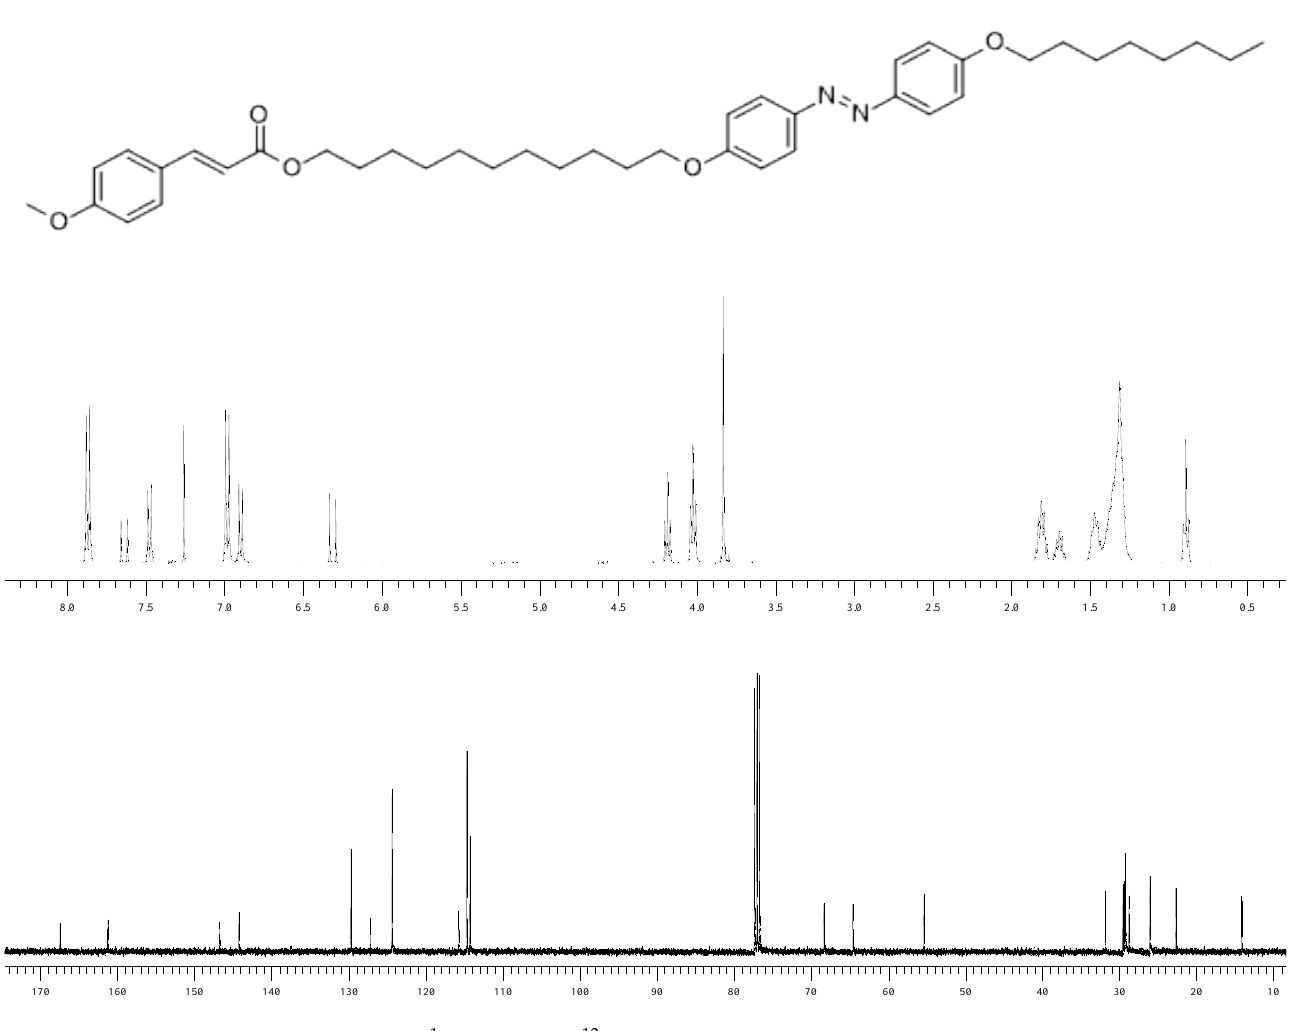
Figure 2. 1 H NMR and 13 C NMR spectral data of ( E )-11-(4-(( E )-(4-(octyloxy)phenyl)diazenyl)phenoxy)undecyl 3-(4-methoxyphenyl)-acrylate ( 1a ).